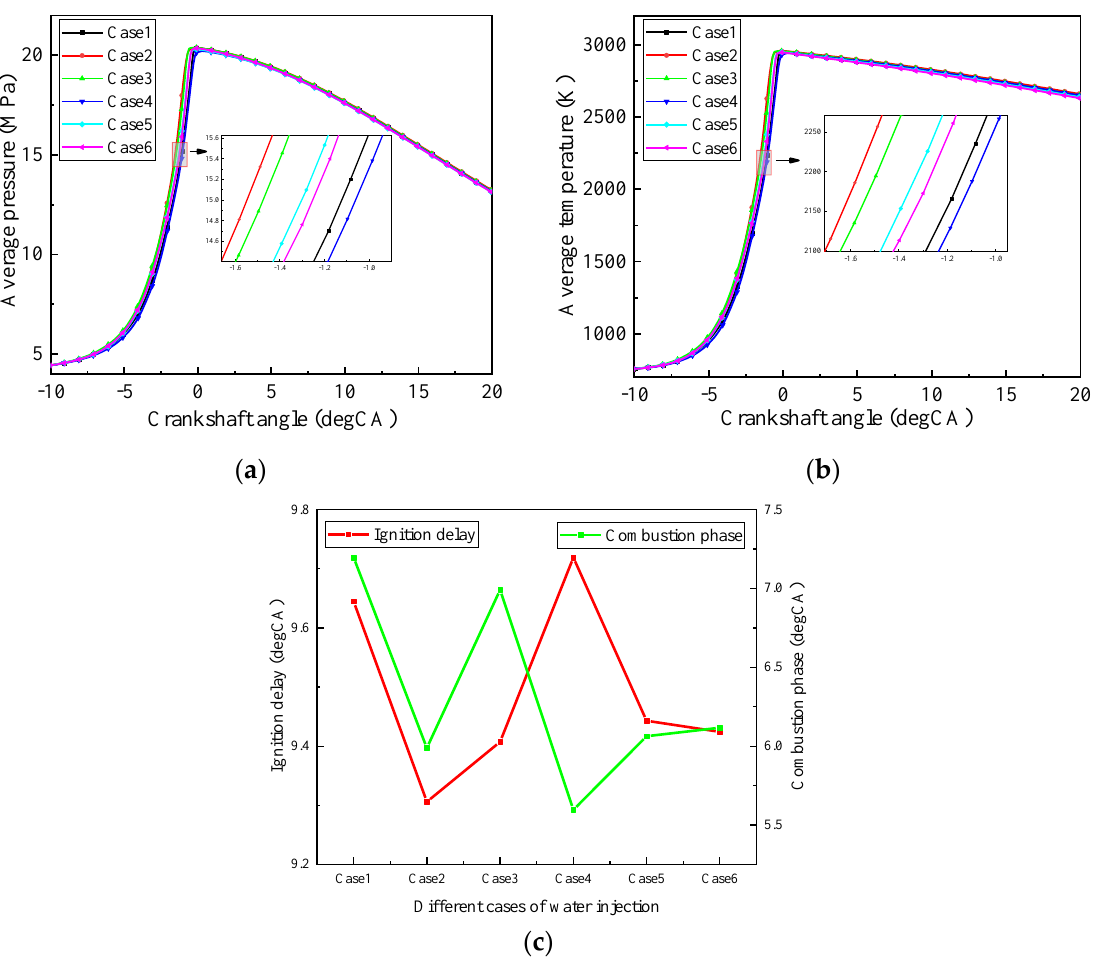
Different cases of water injection Figure 11. Mean equivalence ratio in cylinder at ignition time in different water injection cases (CR = 10.3, ignition time = − 14 degCA). 3.2. Different Water Injection Cases: Combustion Characteristics and Knock Suppression Figure 12a,b shows the average pressure and temperature in the cylinder for different water injection cases. It can be seen that the different water injection cases have little effect on the peak pressure and temperature in the cylinder, but affect the combustion rate. Fig- ure 12c shows the ignition delay and combustion phase for different water injection cases. The ignition delay is defined as the time between the moment of ignition and the 10% mass fraction combustion position, and the combustion duration is defined as the time